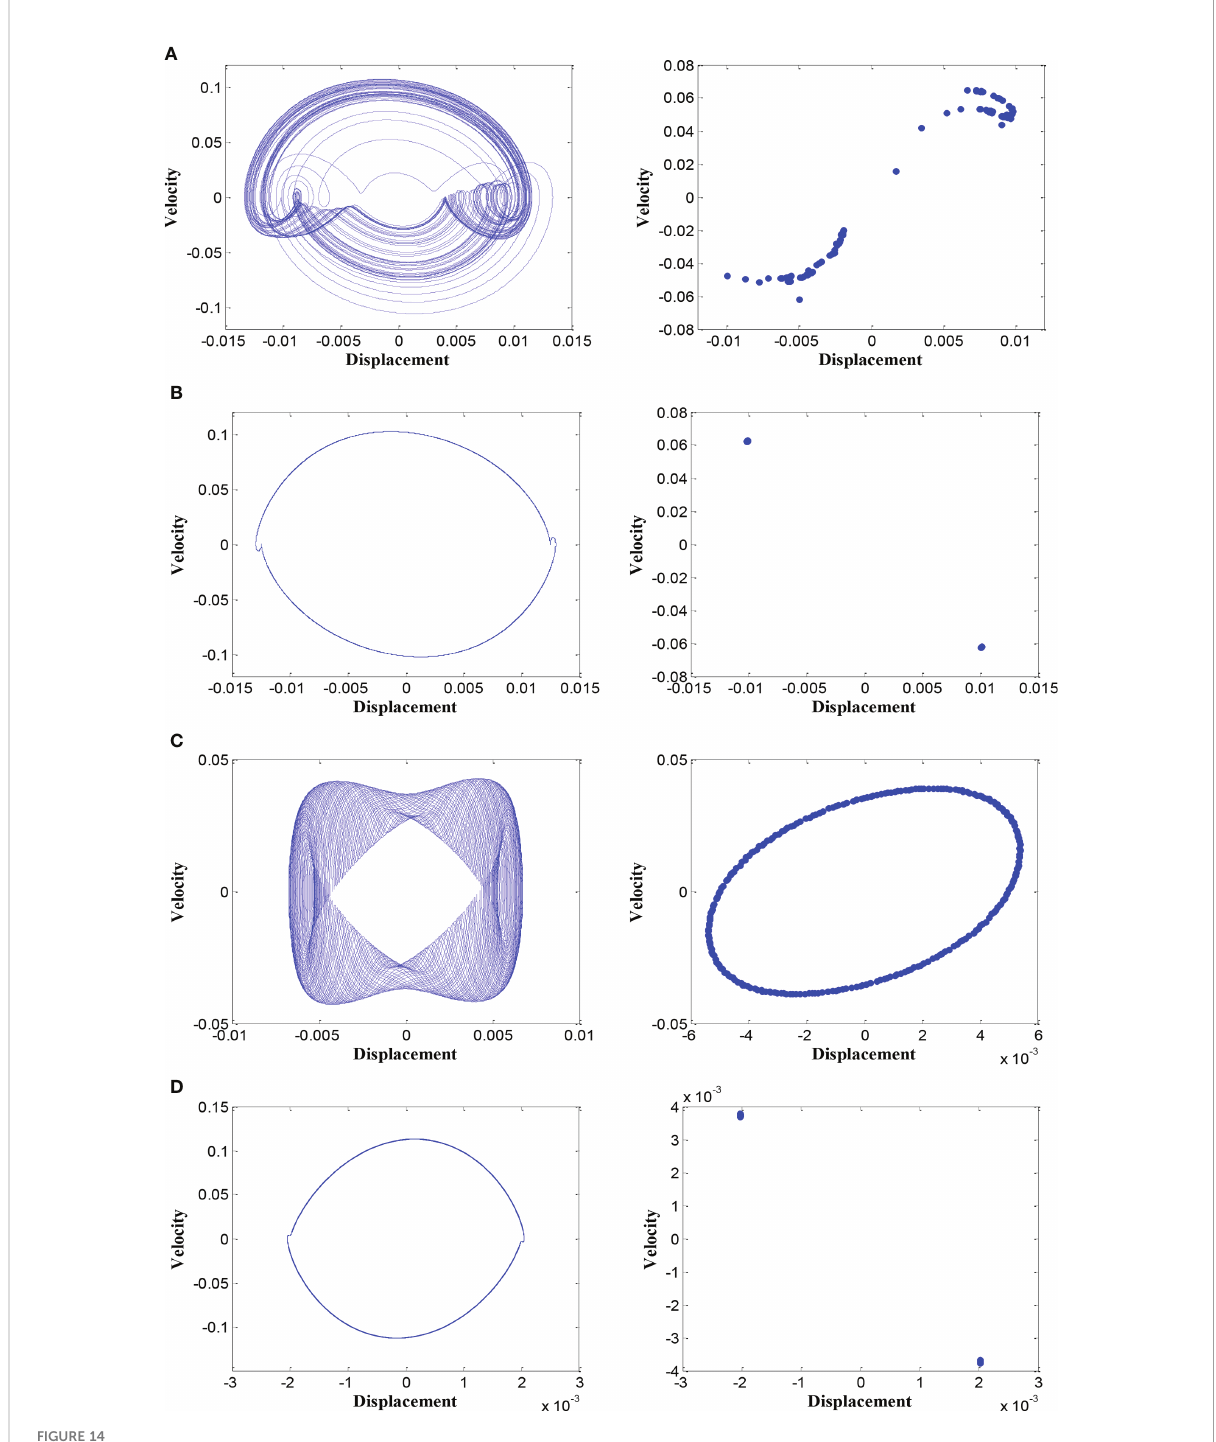
FIGURE 14 Phase trajectory map (left) and Poincare ́ map (right) of the system at different pulsating frequencies (when m = 0.6). (A) w p = 8; (B) w p = 10; (C) w p = 39; (D) w p =